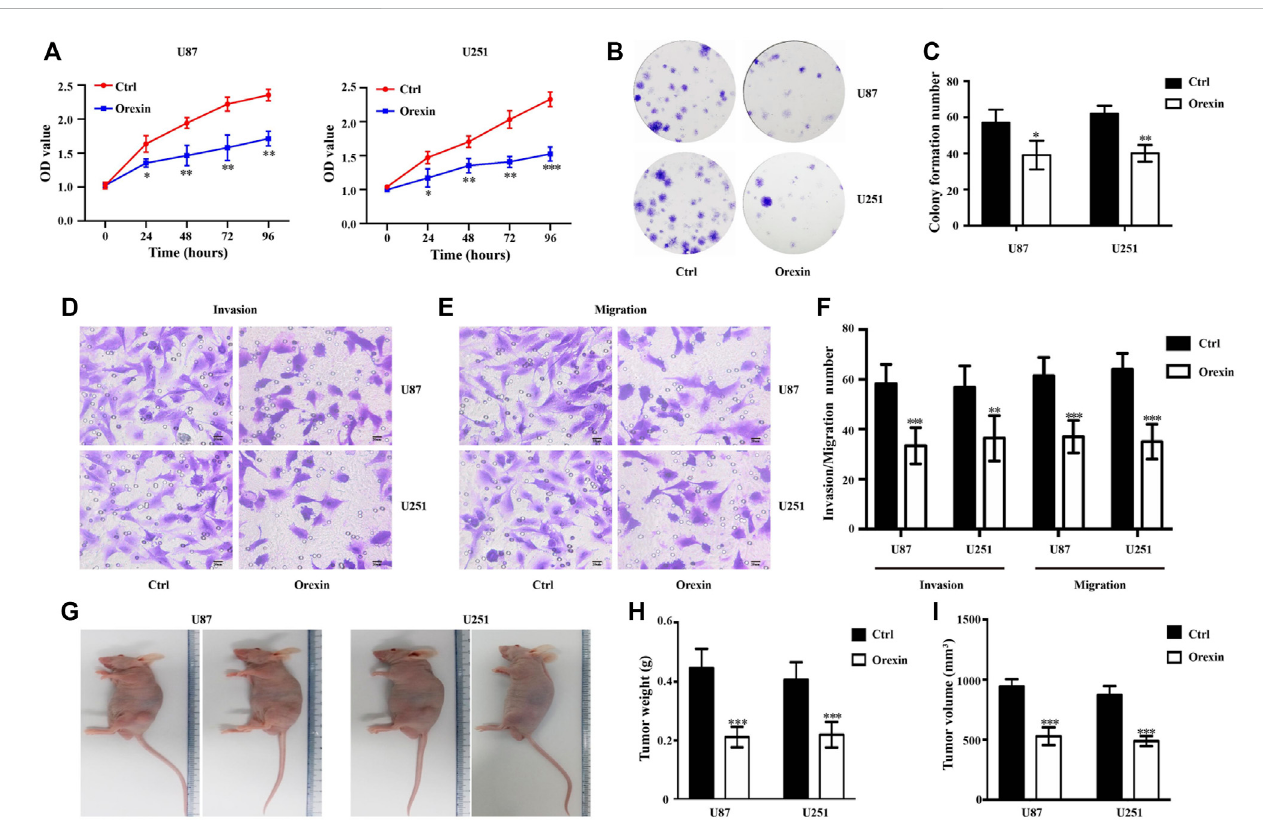
FIGURE 6 OrexinA (OXA) inhibited theproliferation, migration, and invasion ofglioma. (A) Effects ofOXA treatment on cell proliferation by CCK-8inU87 and U251 cells. (B) Effects and (C) statistics of OXA treatment on cell proliferation by colony formation assays in U87 and U251 cells. Effects of OXA treatment on cell migratory (D) and invasive (E) capacities by transwell assays in U87 and U251 cells, and the statistical information (F) of the invasive and migrated glioma cells withorwithoutOXAexposure. (G) Observationofthefeaturesoftumorweightandvolumeinsubcutaneousxenograftmousemodels. (H) Tumorweight and (I) volume of xenografts derived from U87 and U251 cells. * p < 0.05, ** p < 0.01, *** p <